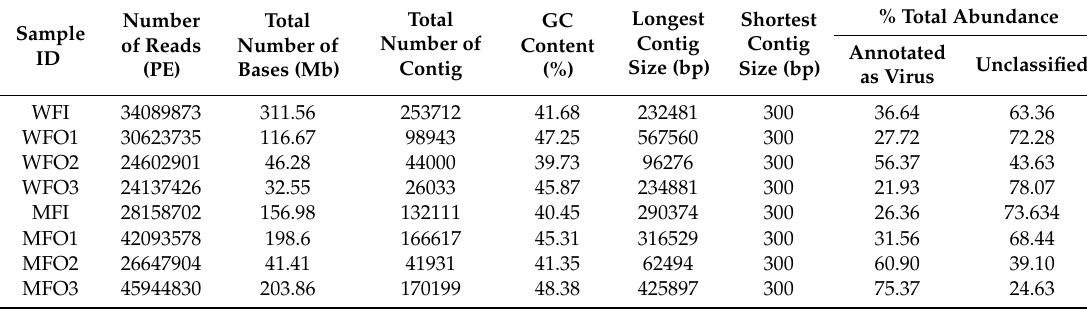
Table 1. The result of virome sequences from oil reservoir production water samples.